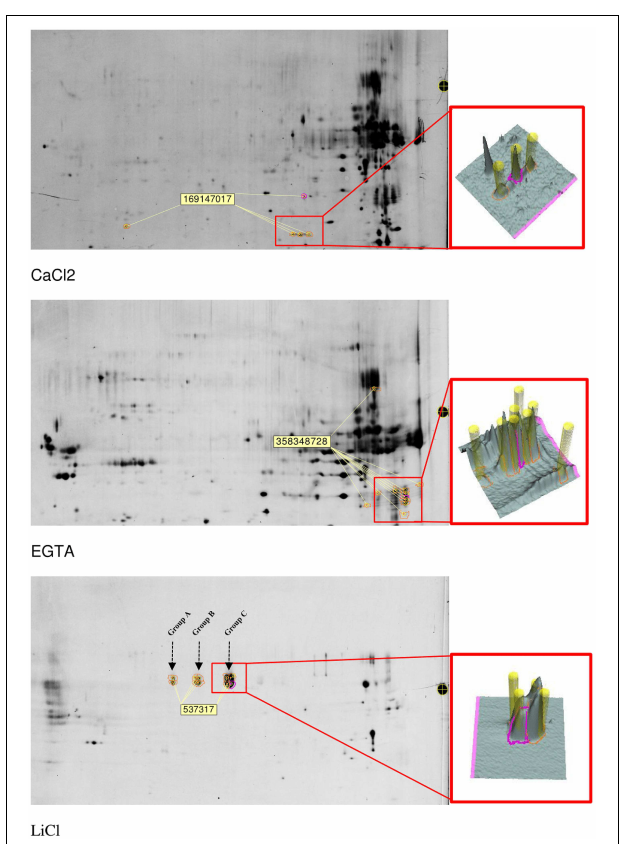
FIGURE 7 | Localization of some protein isoforms detected after spot detection, picking, digestion, and identification. In the LiCl fraction, three groups of spots containing peroxidase were identified and arbitrary named group A, B, and C for further MALDI-TOF/TOF characterization.